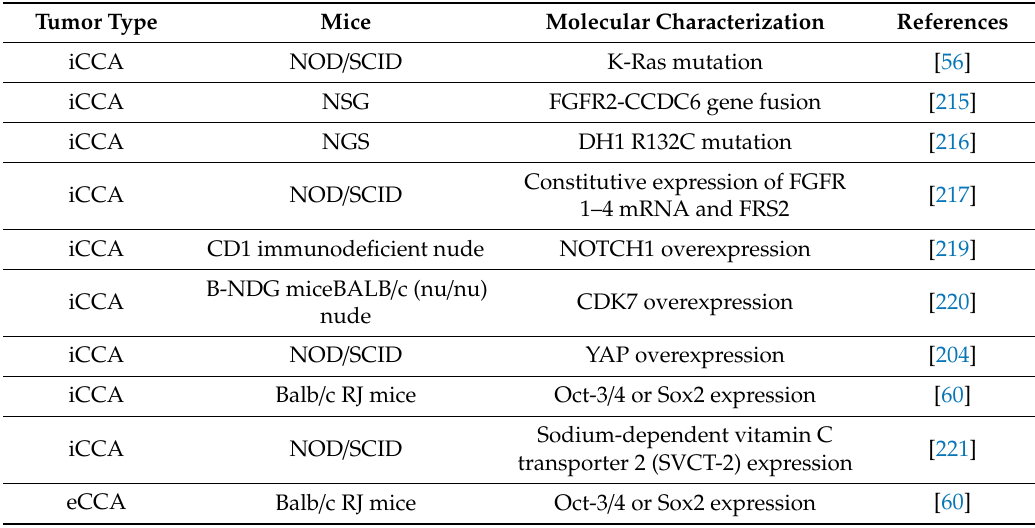
Table 4. Representative and characterized CCA patient-derived xenograft (PDX)